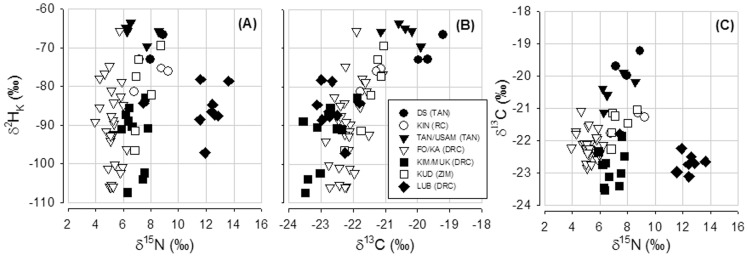
Relationships between stable isotope ratios of carbon, nitrogen and hydrogen measured in fur keratin of Epomophorus wahlbergi and E. crypturus.(A) Relationship between hydrogen and nitrogen stable isotope ratios, (B) relationship between hydrogen and carbon stable isotope ratios, (C) relationship between carbon and nitrogen stable isotope ratios. Each symbol represents one individual. Localities are indicated according to the legend. Abbreviations: DS = Dar es Salaam (Tanzania), KIN (RC) = Kinshasa (Republic of Congo), TAN/USAM (TAN) = Tanga, Usambara (Tanzania), FO/KA = Forzt/Kaloba (Democratic Republic of Congo), KIM/MUK (DRC) = Kimbongo/Mukulakula (Democratic Republic of Congo), KUD (ZIM) = Kudzwe (Zimbabwe), LUB = Lubumbashi (Democratic Republic of Congo).